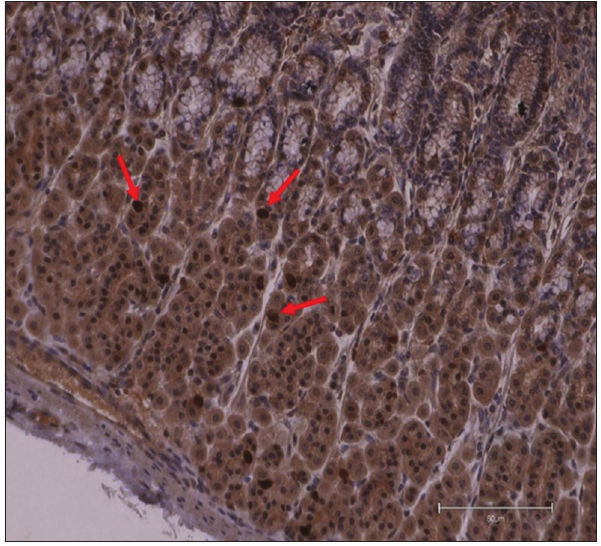
Figure-2: Ghrelin immunoreactive + cells (arrows) in a 13-week-old calf from the control group in the abomasum pars fundalis (200×, DAB + hematoxylin, scale bar 50 µ